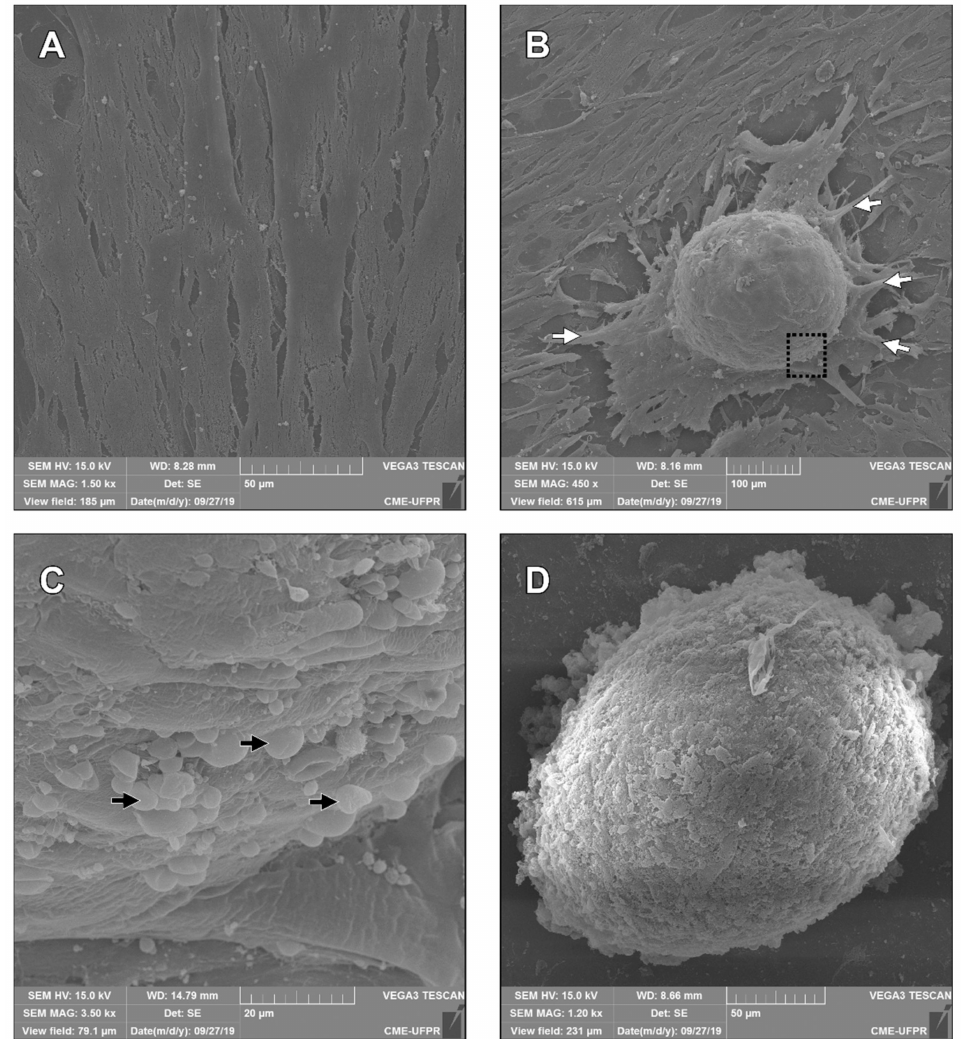
Figure 4. Neurospheres by scanning electron microscopy. ( A ) MSC-WJ reached confluency; ( B ) Neuro- spheres began to be formed by the MSC-WJ, these cells-initiated pseudopod projections for grouping and anchoring and began spherical organization (white arrows); ( C ) Cells that migrated and took part in the neurospheres formation (black arrows); ( D ) neurospheres formed by the MSC-WJ organization. SEM: Vega-3LMU, Tescan, Brno, Czech